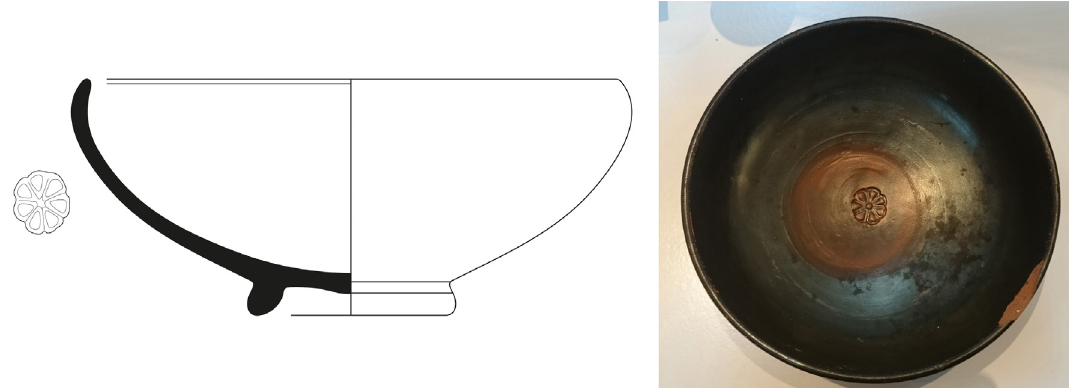
Figure 1. Drawing and photo of a black gloss bowl from the Capistello shipwreck (after Bernabò Brea & Cavalier, 1985, fig. 41, 36. Photo by L.